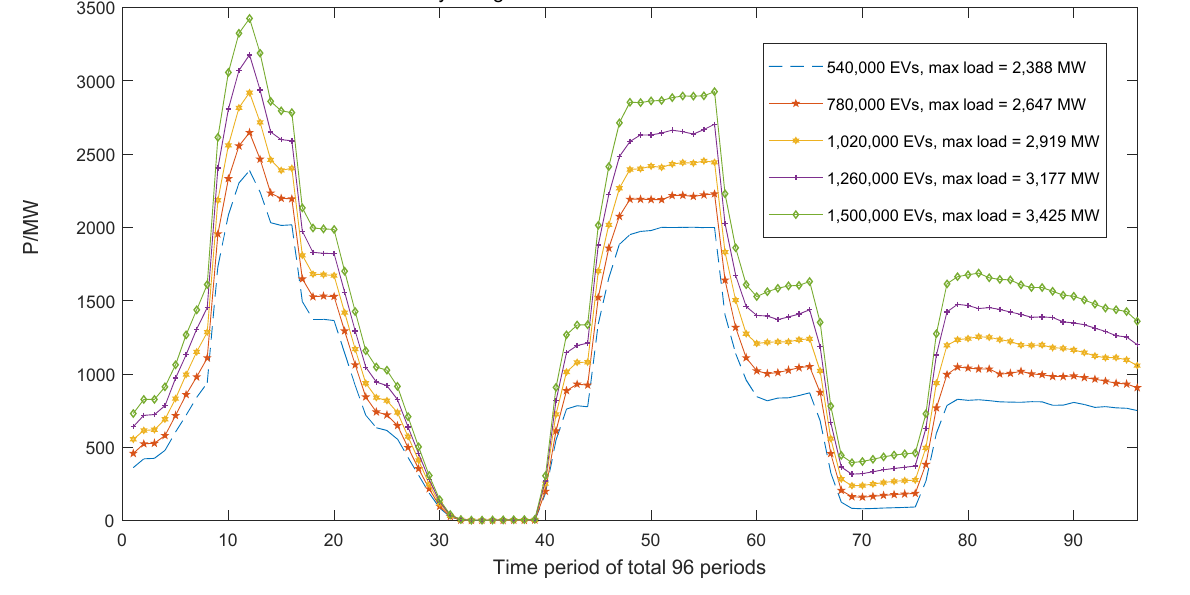
Figure 4. The total charging load curve of private cars, taxis, buses, and official and special vehicles.